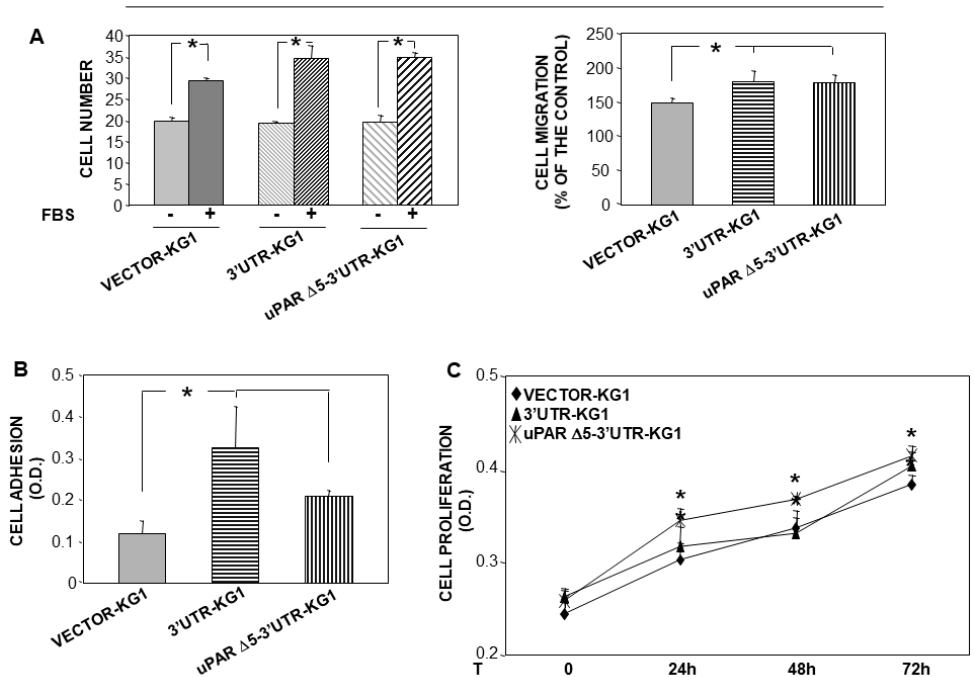
Figure 5. uPAR ∆ 5 variant influences cell adhesion, migration and proliferation. ( A ) KG1 cells were stably transfected with the cDNAs of uPAR ∆ 5 or of 3 (cid:48) UTR of uPAR, or with the empty vector, as control. A total of 2 × 10 5 transfected cells were loaded in Boyden chambers and allowed to migrate towards 10% serum (FBS). Migrated cells were fixed, stained with haematoxylin and counted (left panel). Results of same migration assays are also expressed as percentage of cells migrated towards the chemoattractant over the cells migrated without chemoattractant; 100% value represents cell migration in the absence of chemoattractant. Values are the mean + SEM of three experiments performed in triplicate; * p < 0.05, as determined by the Student’s t -test. ( B ) KG1 cells were stably transfected with the cDNA of uPAR Δ 5 or of uPAR 3 ′ UTR, or with the empty vector, as control. A total of 1.5 × 10 5 transfected cells were plated in wells pre-coated with 10 μ g/mL of fibronectin (FN) or 1% BSA-PBS as a negative adhesion control, and incubated for 2 h at 37 °C, 5% CO 2 . Attached cells were fixed with 3% PFA and stained with crystal violet; the stain was eluted and its absorbance at 540 nm was measured with a spectrophotometer. Values corresponding to cells plated on FN were subtracted of values corresponding to cells plated on BSA. The values are the mean + SEM of six experiments performed in triplicate; * p < 0.05, as determined by the Student’s t- test. ( C ) KG1 cells,